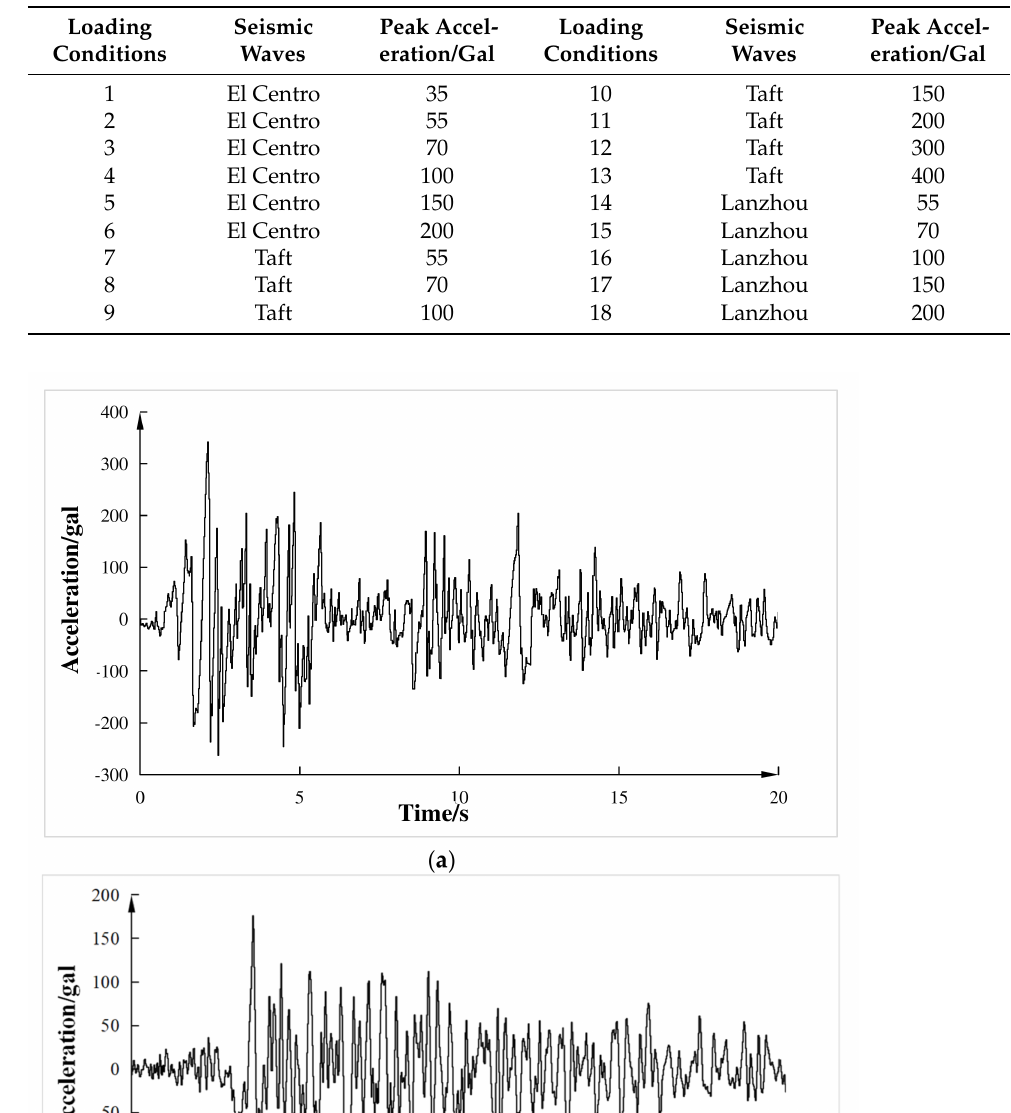
Table 4. Pseudo-dynamic loading conditions.